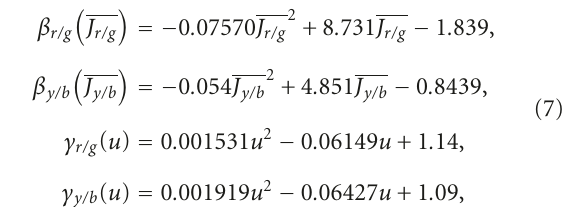
Figure 1: Di ff erence by the direction of